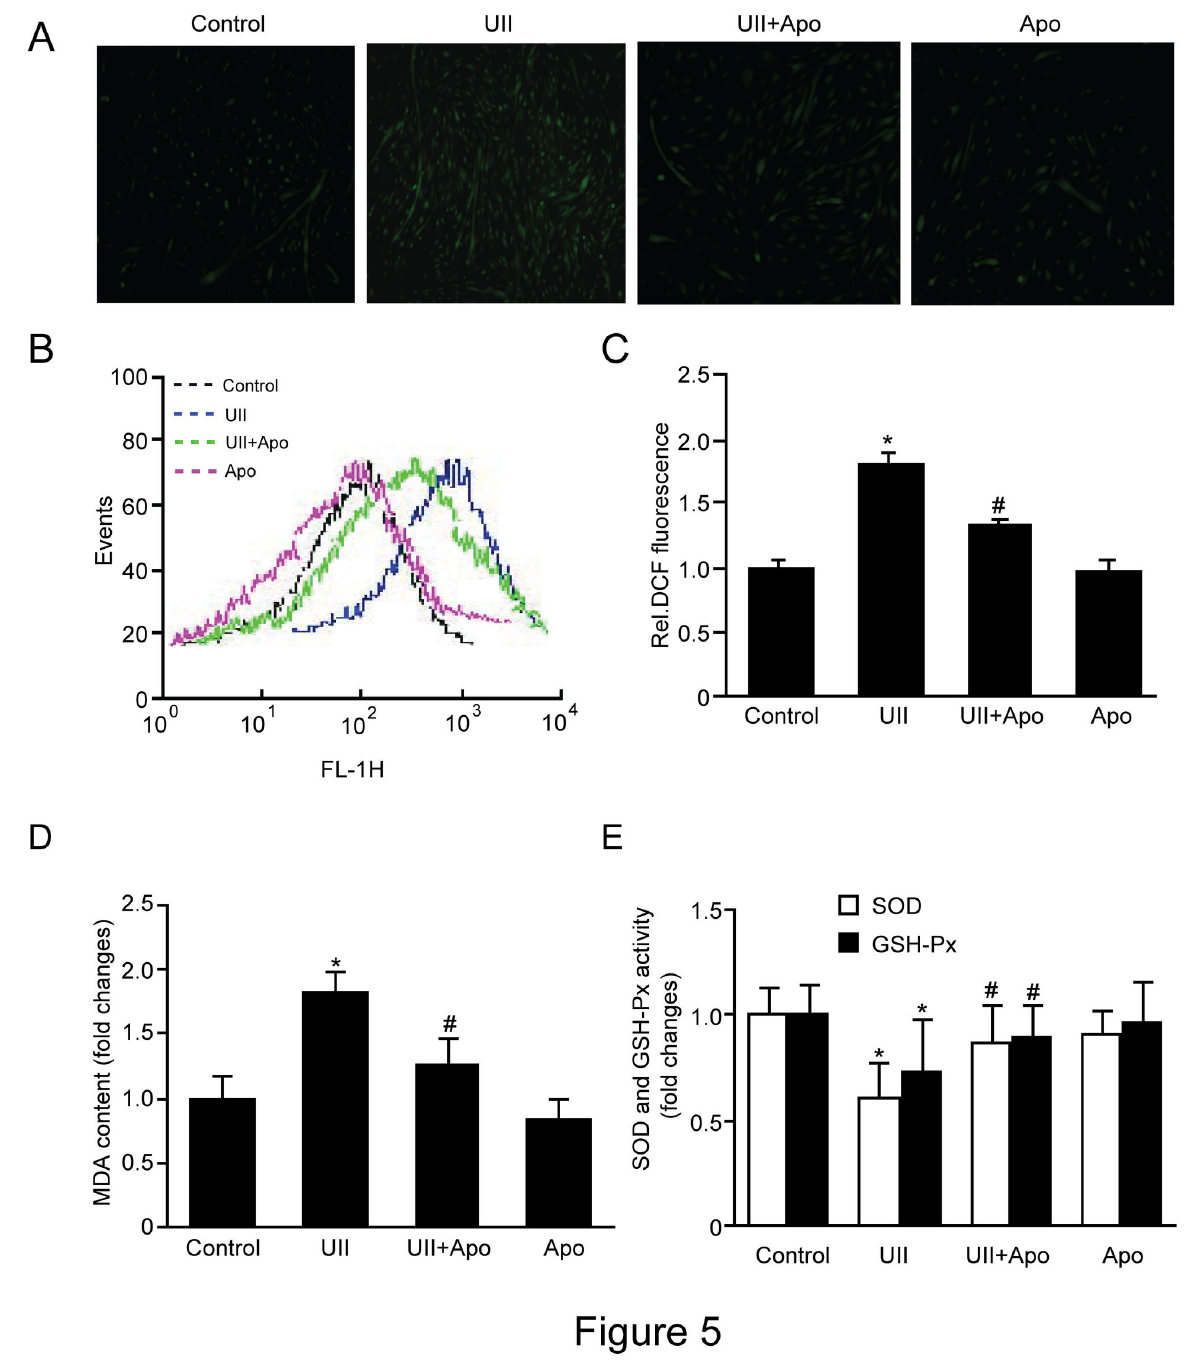
Figure 5. Effect of UII on ROS production, MDA content and antioxidase activity. C2C12 cells were stimulated with 100 nM UII for 2h, and apocynin was administrated for 30 minutes before stimulation with UII. ( A ) ROS levels were visualized by DCF staining (n=3). ( B ) ROS levels were assessed by DCF fluorescence using flow cytometry (n=3). ( C ) ROS levels were evaluated by DCF fluorescence in a microplate reader. ( D ) MDA content was measured by the thiobarbituric acid assay. ( E ) SOD and GSH-Px activity were measured using a Glutathione Assay Kit. Control: cells were incubated with fresh FCS free DMEM for 24h; Apo: cells were incubated with fresh FCS free DMEM containing 200 µmol/L apocynin for 24h; UII: cells were treated with UII (100 nmol/L) for 24h; UII+Apo: cells were treated with apocynin (200 µmol/L) for 30min, and then incubated with UII for 24h. Data are presented as the relative increase compared with control (100%; n=6-8, * P <0.05 vs control group; # P <0.05 vs UII group). doi: 10.1371/journal.pone.0076796.g005 PLOS ONE |